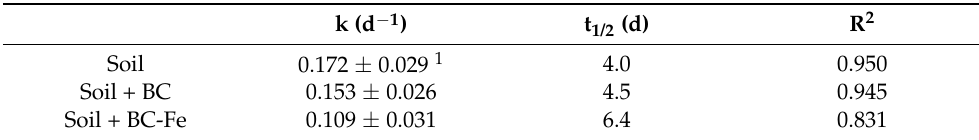
Table 3. Single first-order dissipation constants and half-lives for SFA in untreated and soil treated with BC and